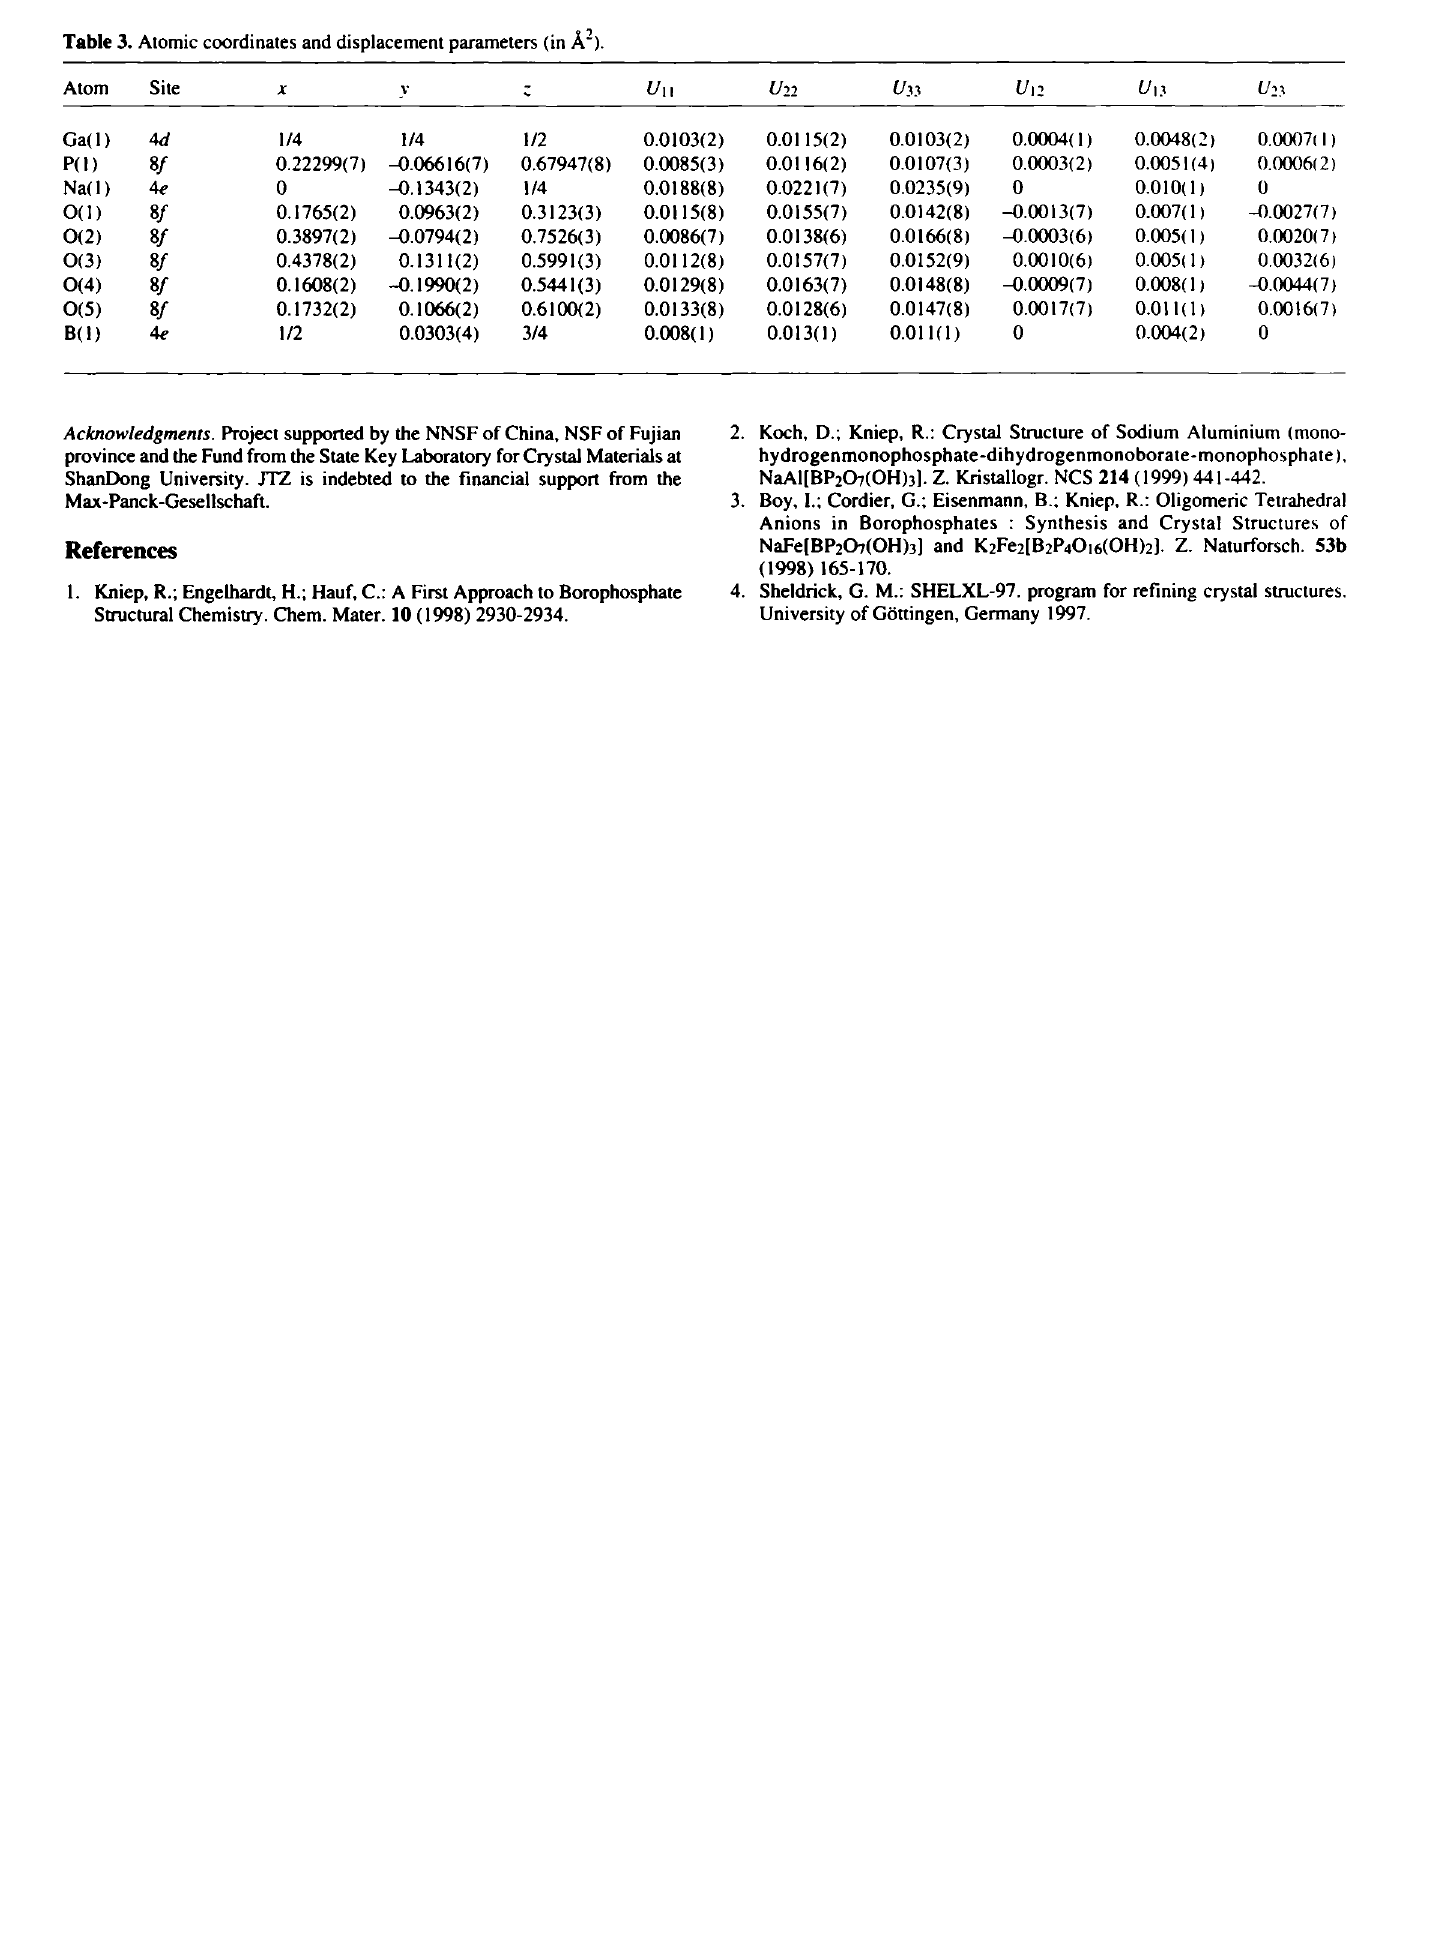
Table 3. Atomic coordinates and displacement parameters (in Ä 2